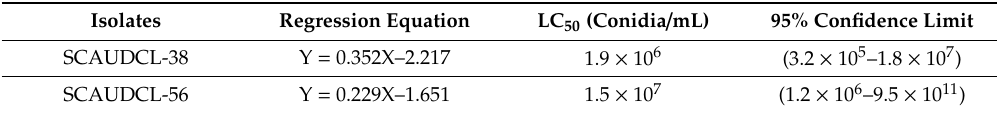
Figure 3. Corrected mortality of Megalurothrips usitatus at five days post-inoculation with different conidial concentrations of A. attenuates isolates. Different lowercase letters above the bar for each isolate indicate signi fi cant differences at the level of p < 0.05 determined by Tukey’s HSD test. Table 3. Median lethal concentration (LC 50 ) values for A. attenuatus isolates SCAUDCL-38 and SCAUDCL-56 against M. usitatus after five days of fungal treatment.